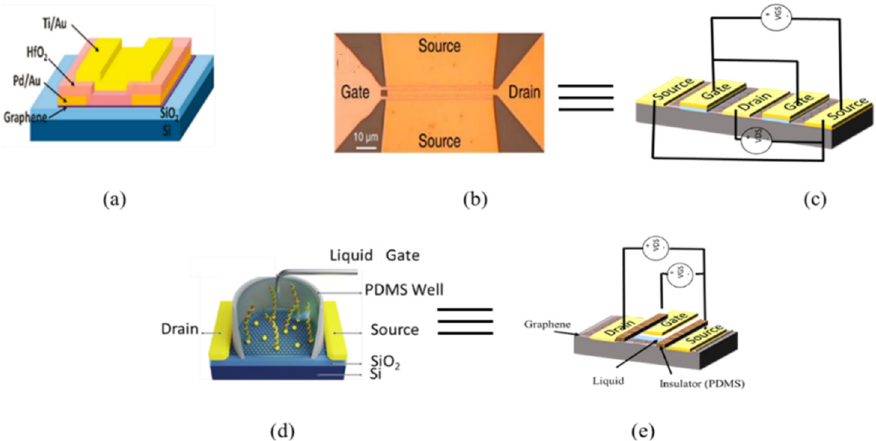
Figure 2. Top-gated graphene transistors: ( a ) single-gate [16]; ( b ) two-fingers [18]; ( c ) topology of the two-fingers transistor; ( d ) top-liquid gate [19]; and ( e ) topology of the top-liquid gate.